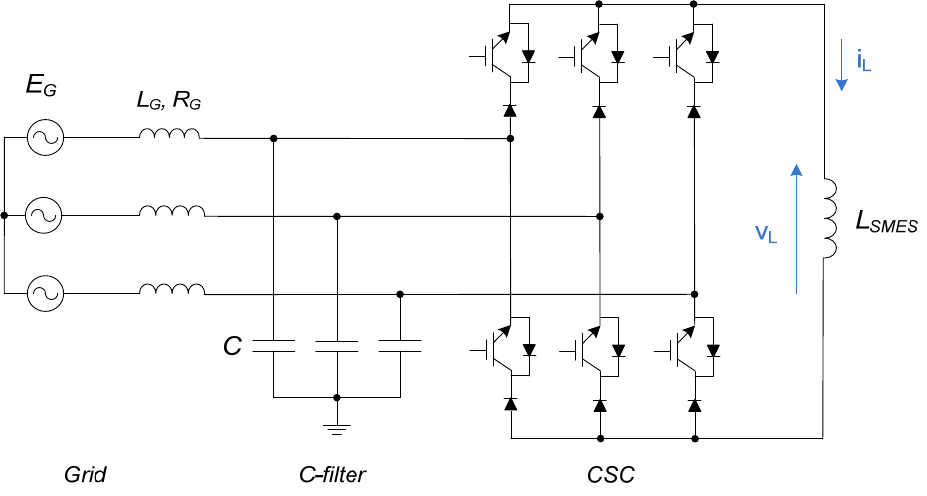
Figure 6. Power conditioning system based on a two-level